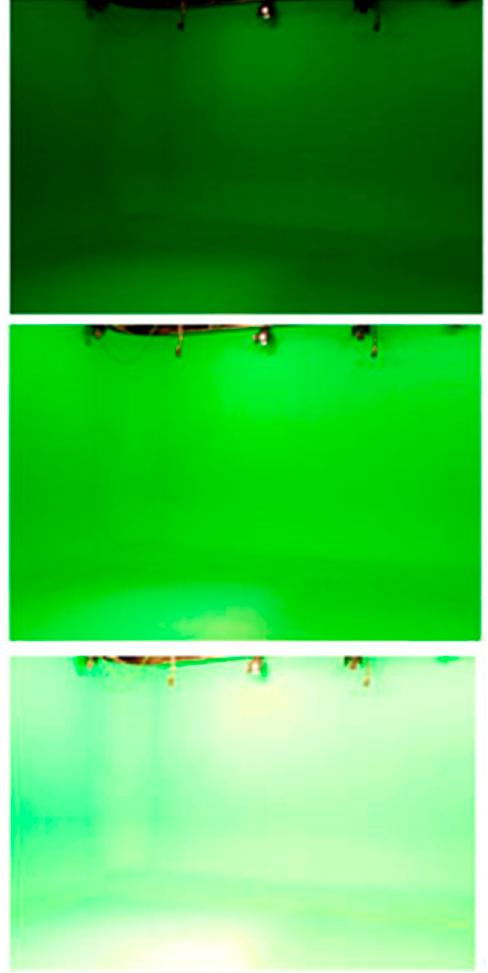
Figure 3. Cyclorama photographs captured using three different shutter speeds.